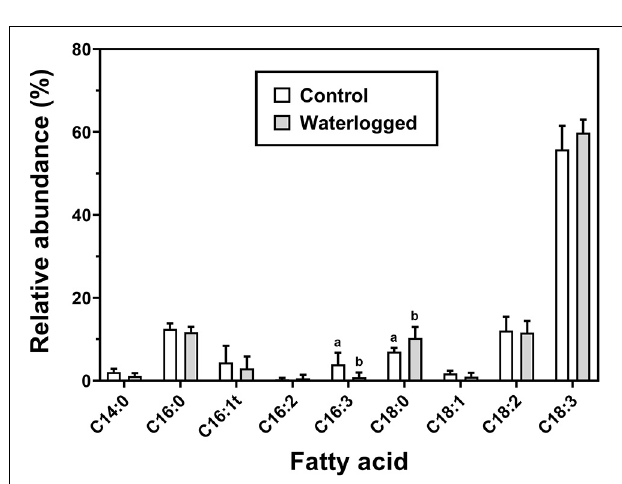
FIGURE 12 | Fatty acid profile in leaves of control plants (white boxes) and waterlogged plants (gray boxes) of Spartina patens after 30 days ( n = 5, different letters indicate significant differences at p <